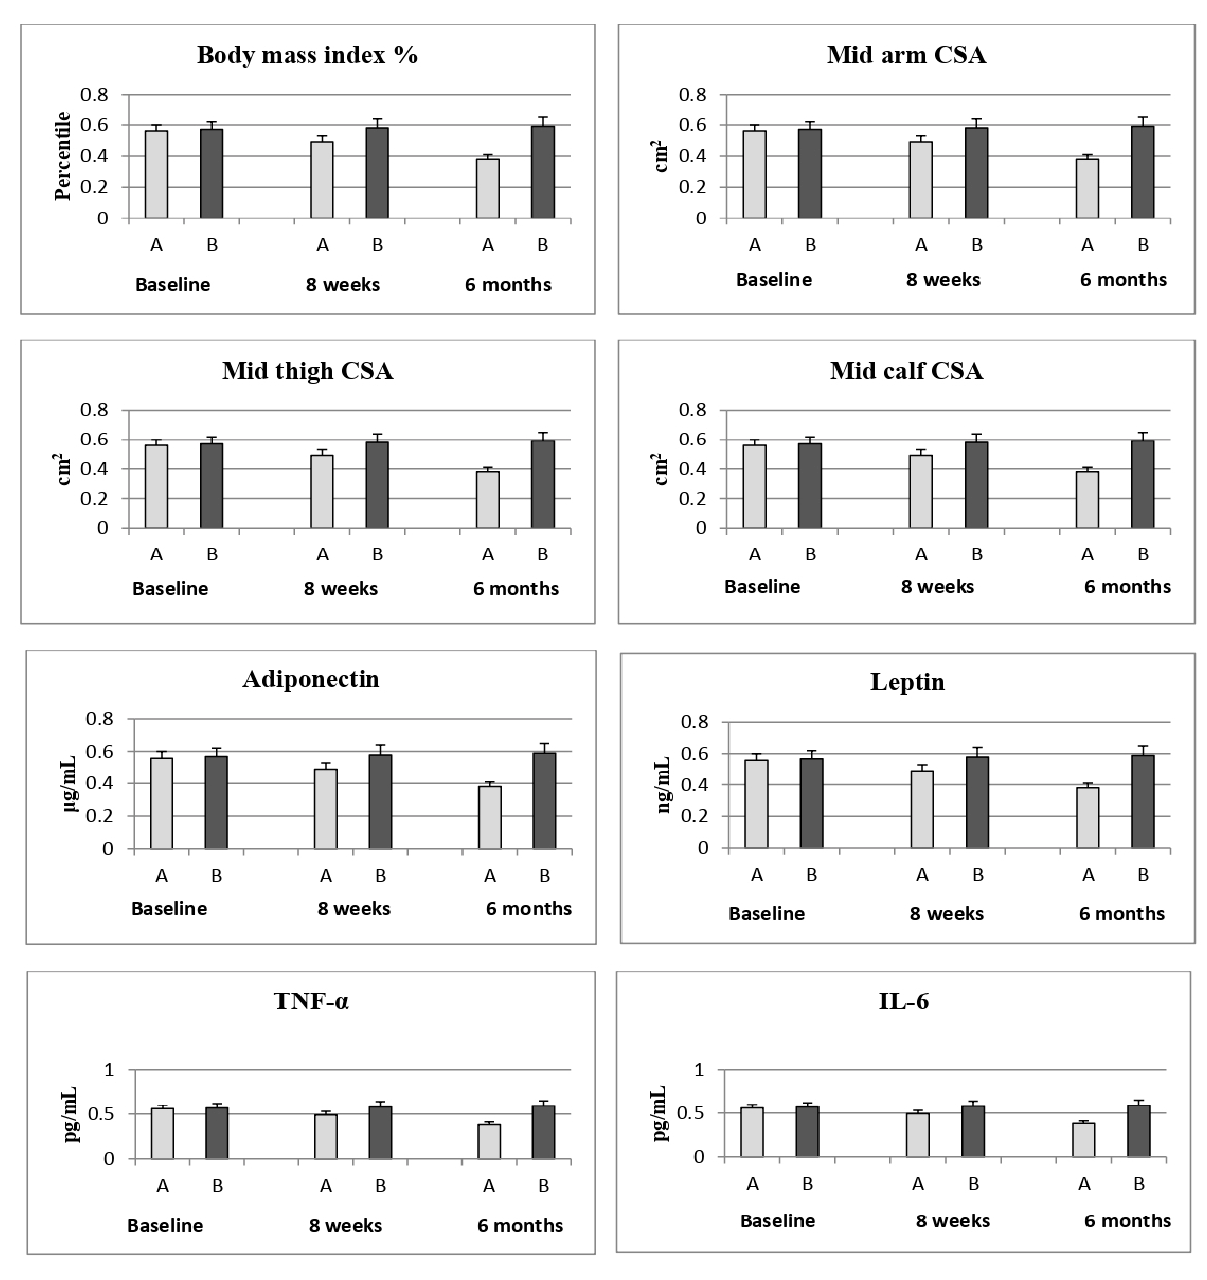
Figure 3. Pre and post primary and secondary outcome measures of Group A and B.